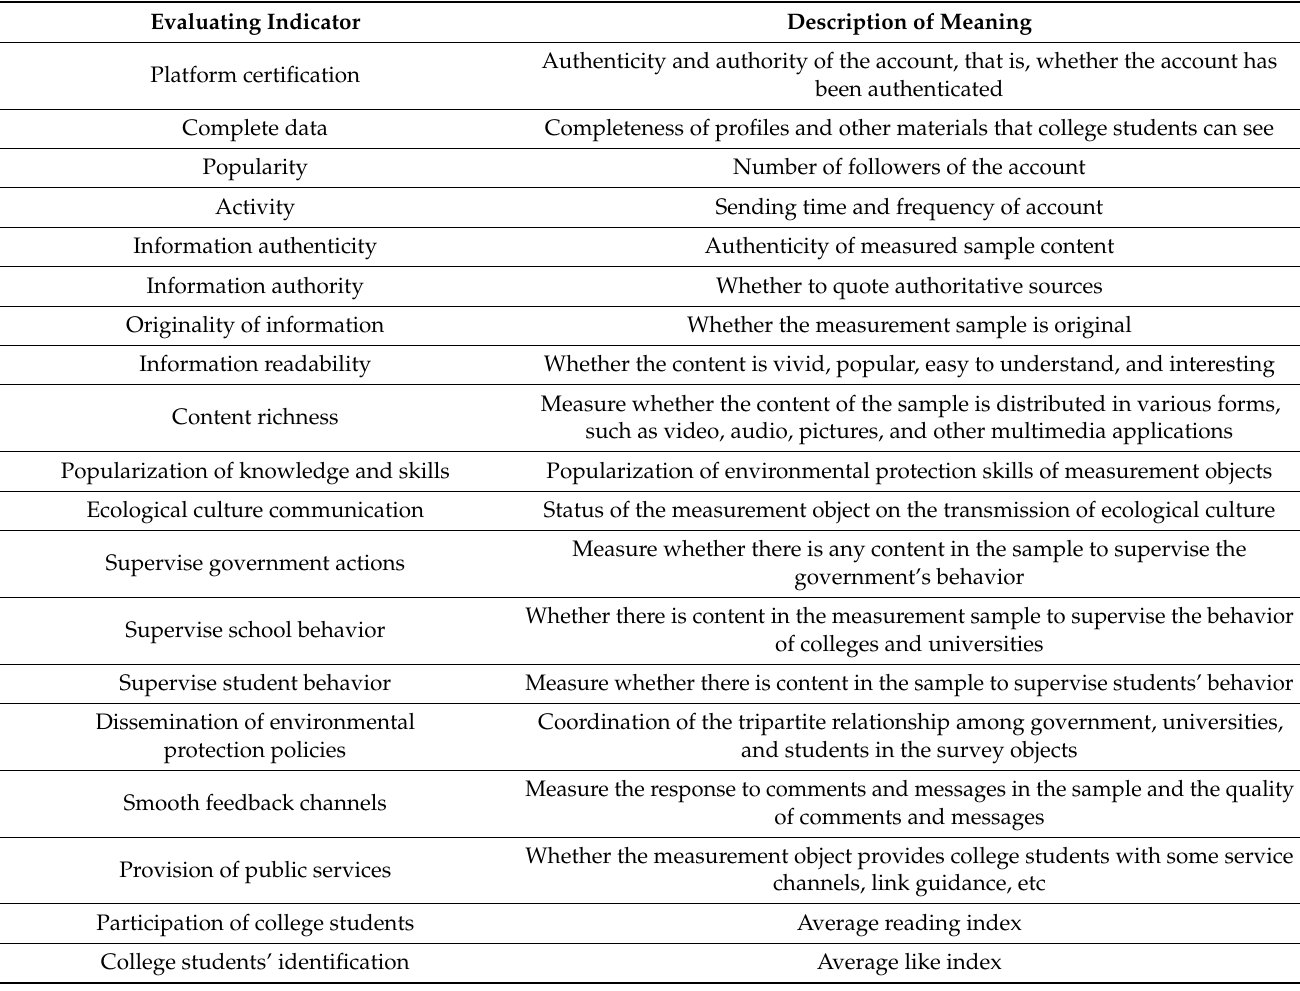
Table 3. Definition of Evaluation